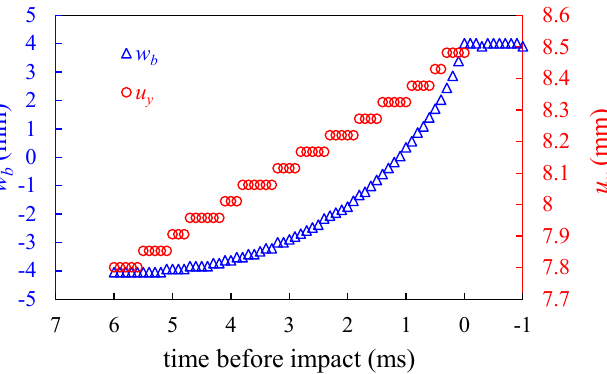
Figure 8. The measured deflection w b of the beam tip and the position u y of the magnet A before impact for the first test.